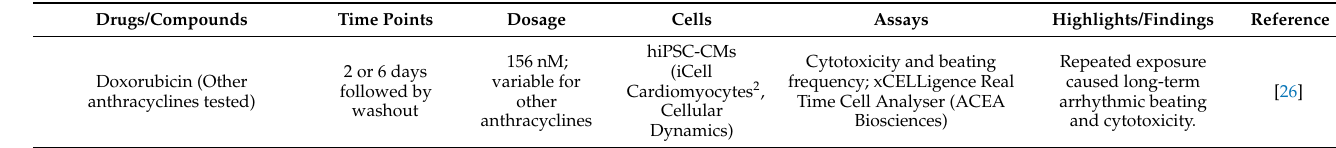
Table 1. Summary of drugs/compounds, dosage and timepoints tested on hiPSC-CMs along with key